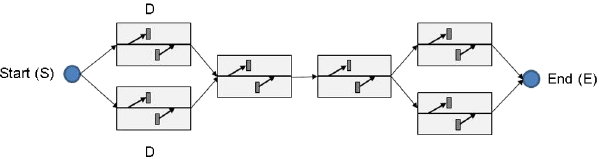
FIG. 5. Model reflecting an open signal path with six compo- nents, including redundant components.